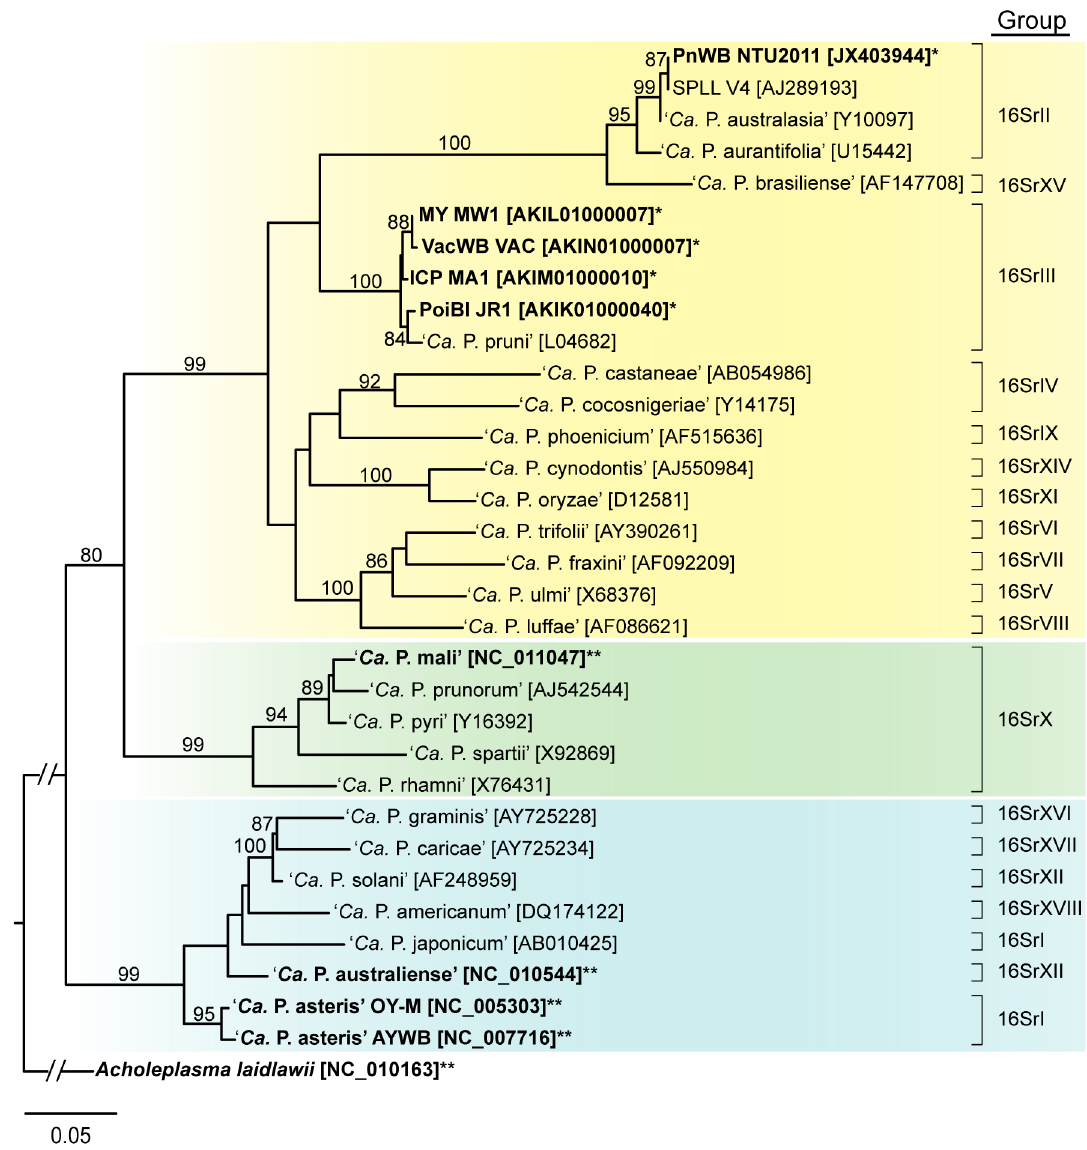
Figure 1. Molecular phylogeny of phytoplasmas. The maximum likelihood tree is inferred based on the 16S ribosomal RNA gene. GenBank accession numbers are listed in square brackets following the species names. The numbers on the internal branches indicate the percentage of bootstrap support based on 10,000 re-sampling (only values . 80% are shown). The sequence from Acholeplasma laidlawii is included as the outgroup. The species with genome sequences available are highlighted in bold (*partial; **complete). Abbreviations: peanut witches’-broom phytoplasma strain NTU2011 (PnWB NTU2011); sweet potato little leaf phytoplasma strain V4 (SPLL V4); milkweed yellows phytoplasma strain MW1 (MY MW1); Vaccinium witches’-broom phytoplasma strain VAC (VacWB VAC); Italian clover phyllody phytoplasma strain MA1 (ICP MA1); poinsettia branch-inducing phytoplasma strain JR1 (PoiBI JR1).